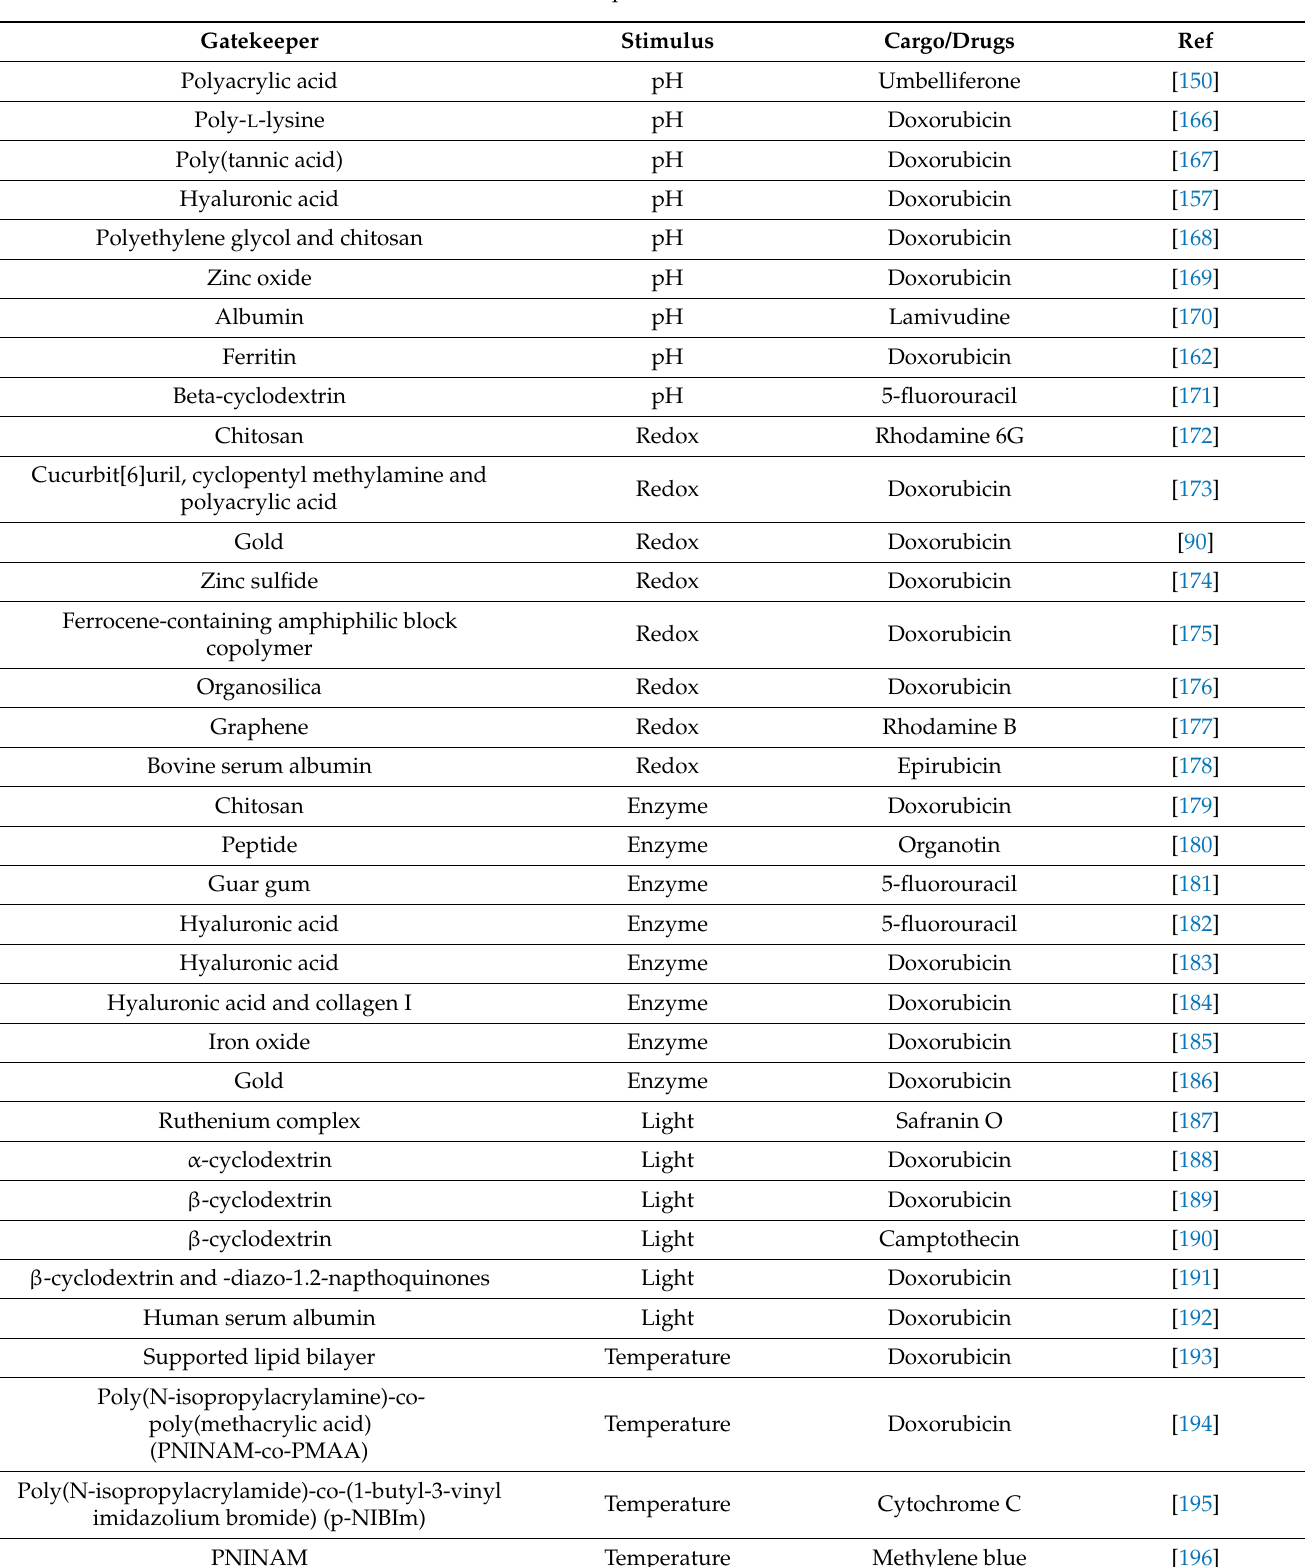
Table 2. Various stimulus-responsive-MSNs for controlled